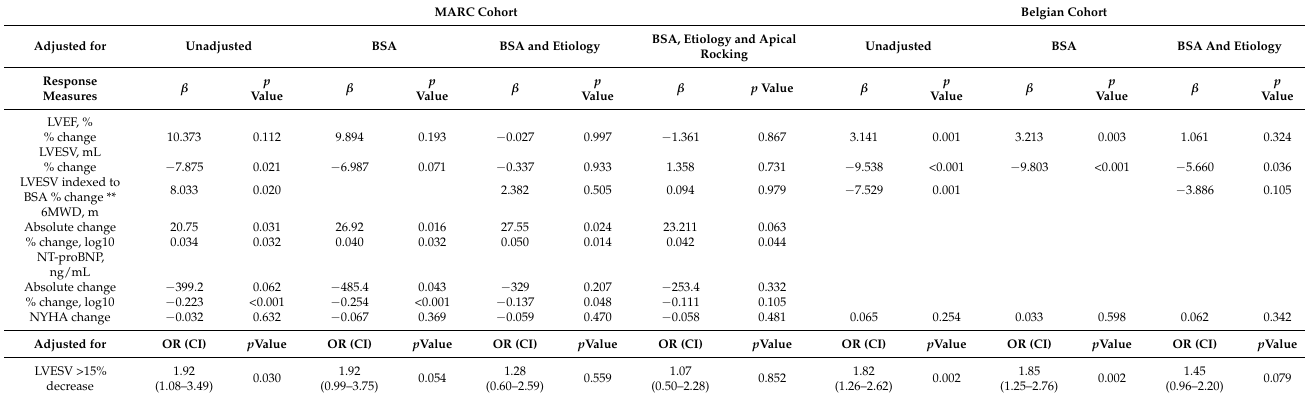
Table 4. Association of sex and response measures at 6 months